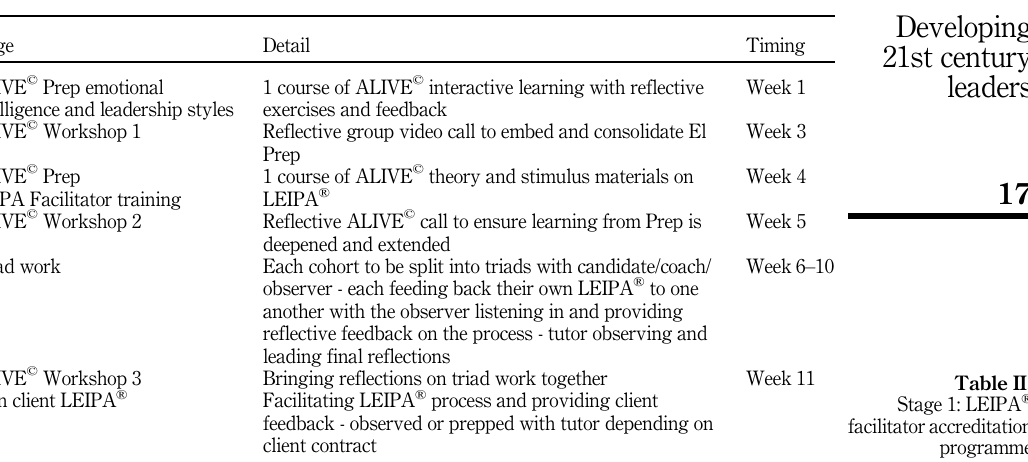
Table II. Stage 1: LEIPA